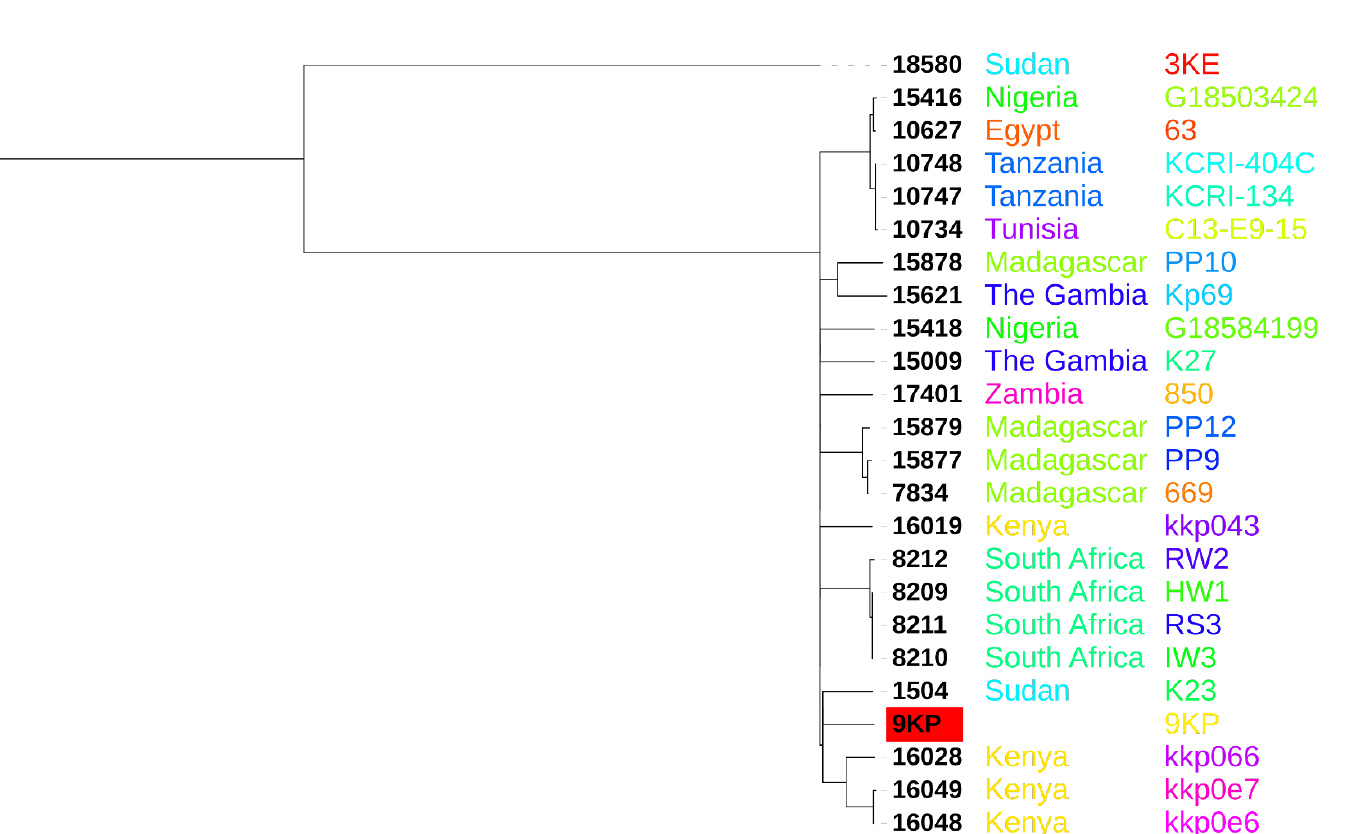
Figure 4. Phylogenomics analysis of K. pneumoniae 9KP (shown in red highlight) compared to African K. pneumoniae strains. Strain 3KE is K. quasipneumoniae used as an outgroup. Numbers in nodes indicate Pasteur MLST isolate IDs.